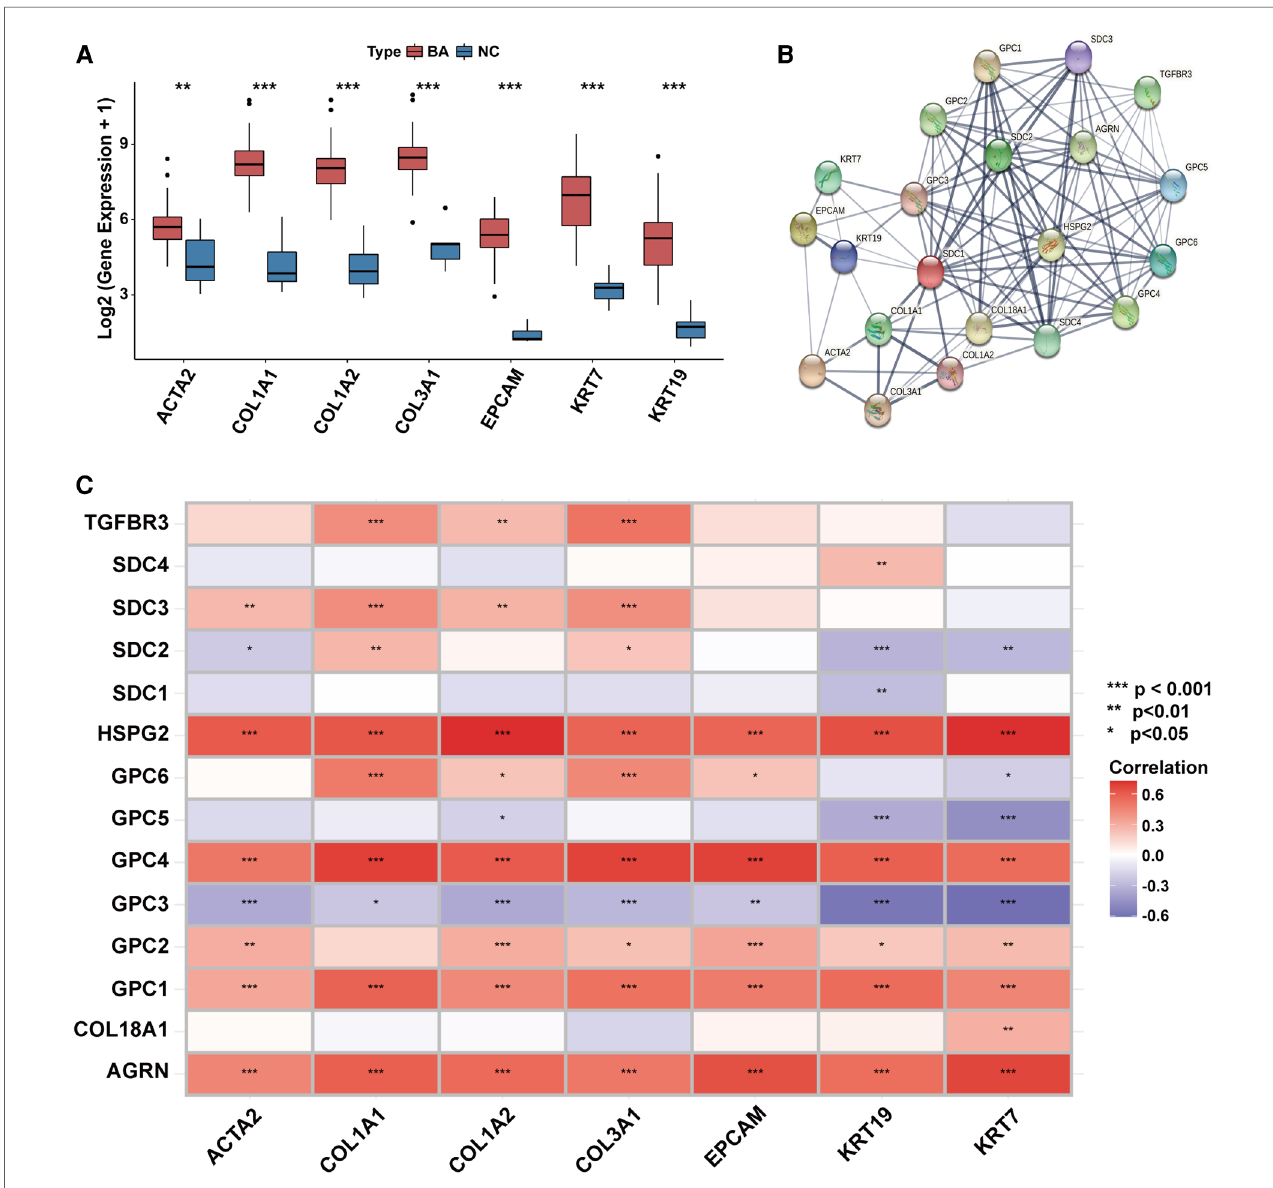
FIGURE 2 The association between the expression of HSPGs and liver fi brosis and ductular reaction in BA. ( A ) Liver fi brosis and ductular reaction indexes expressions in BA and NC livers. ( B ) PPI network of HSPGs, liver fi brosis and ductular reaction indexes. Each node represents a type of protein, and edges connect the interacted index. ( C ) Correlation between HSPGs, liver fi brosis and ductular reaction indexes in BA. Red represents higher correlation and blue represents lower correlation, respectively. HSPG, heparan sulfate proteoglycan; BA, biliary atresia; NC, normal control; PPI, protein-protein interaction. ns, not signi fi cant, * p <0.05, ** p <0.01, *** p